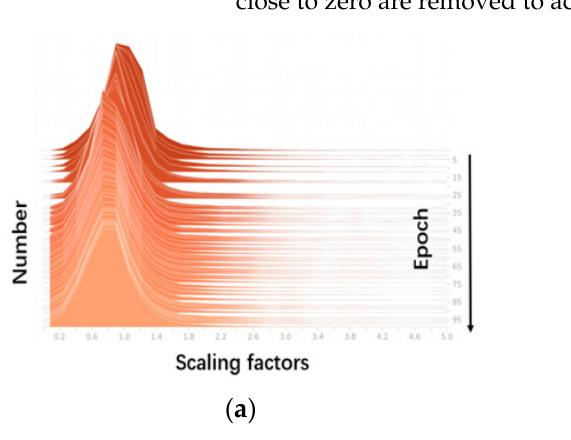
Figure 10. Distribution of BN layer scaling factors ( a ) Original training; ( b ) Sparse training.